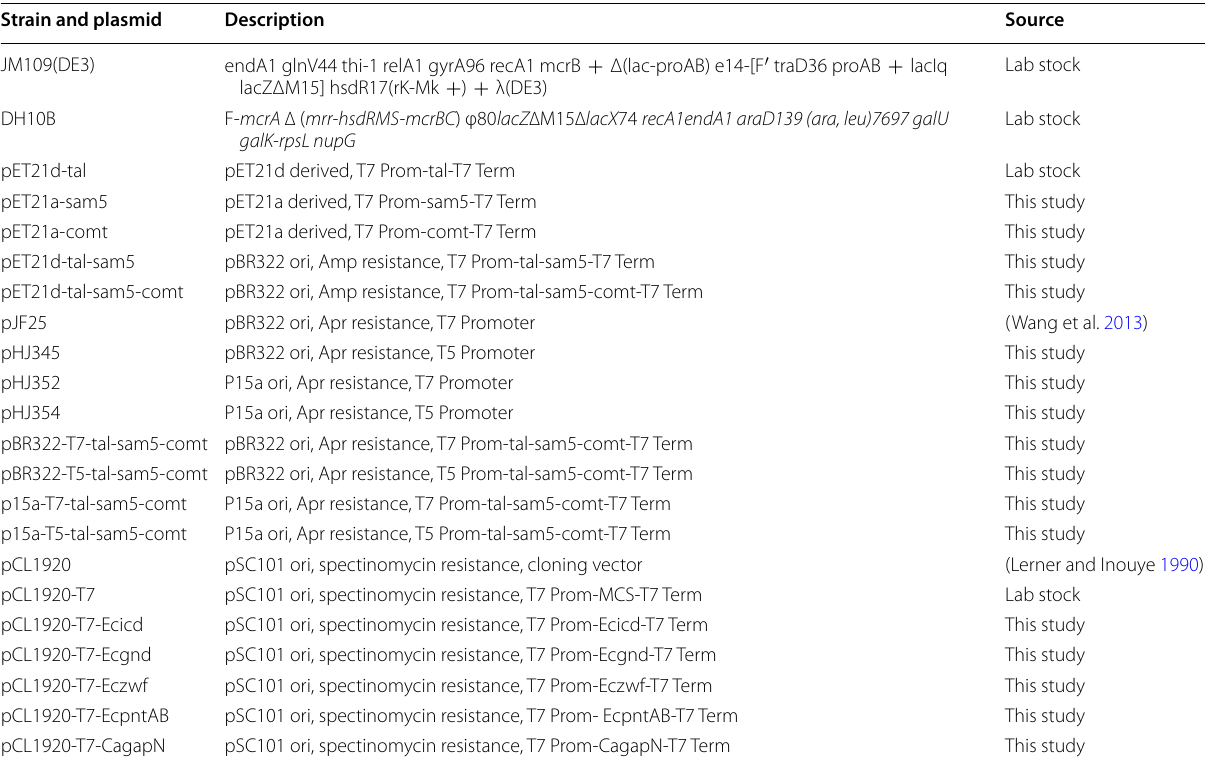
Table 1 The E. coli strains and plasmids used in this study Strain and plasmid